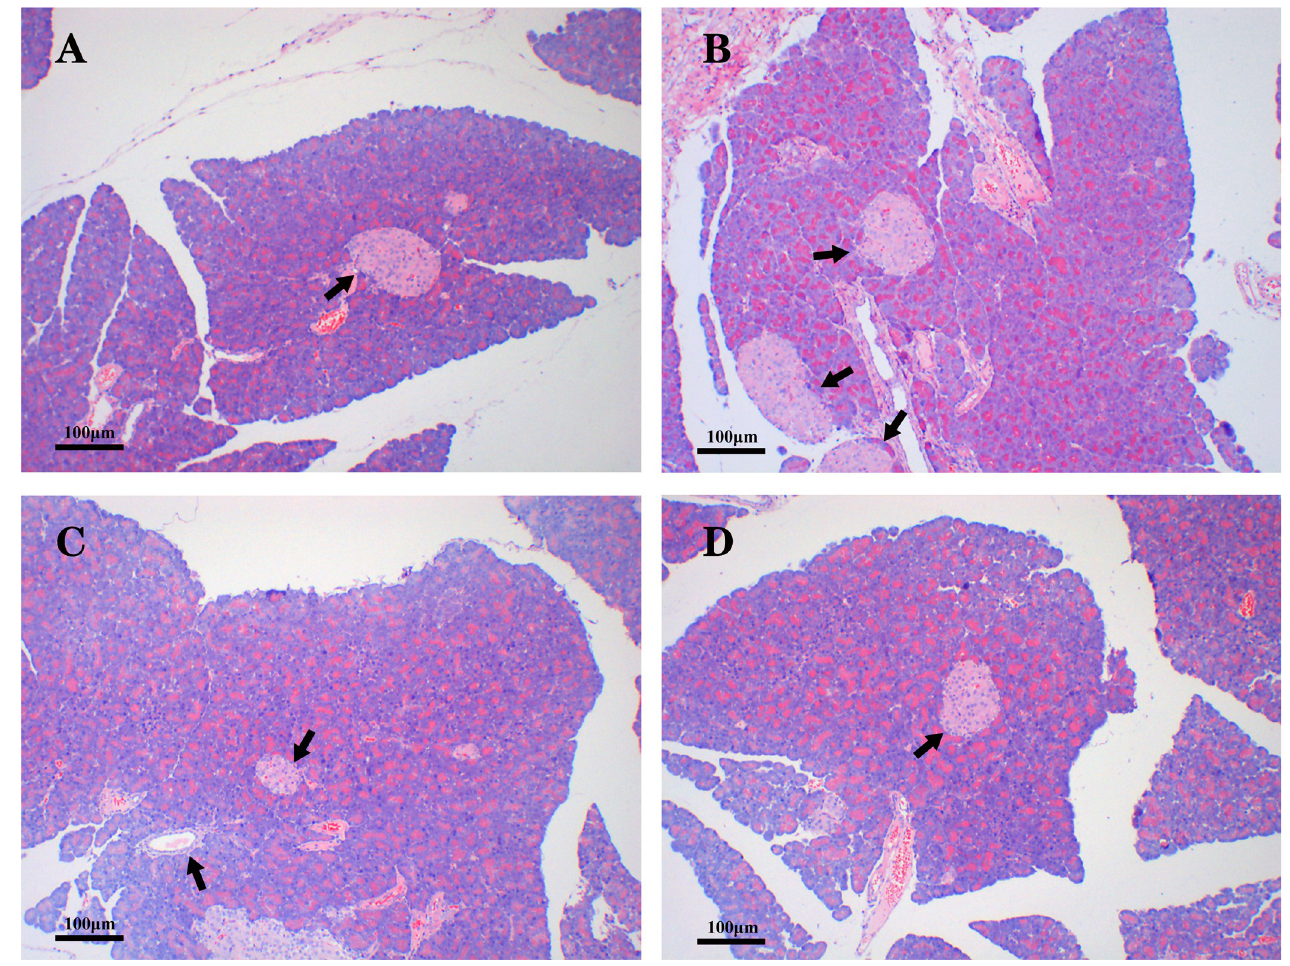
(Table 1). The volcano map shows that the differentially expressed proteins were distributed into two different quadrants (Fig